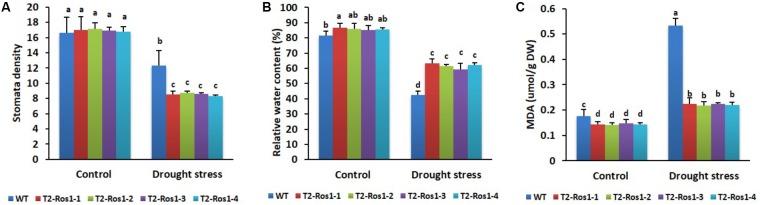
Comparison of leaf stomatal density (A), relative water content (B), and MDA content (C) analyzed from the fourth top leaf of 8-week-old WT and four independent T2-Ros1 lines under the drought stress and normal growth conditions. Data were taken on the 15th day after starting the experiments. Error bars indicate the SE of means of three replicates. Means with different letters are significantly different (DMRT, p < 0.05).